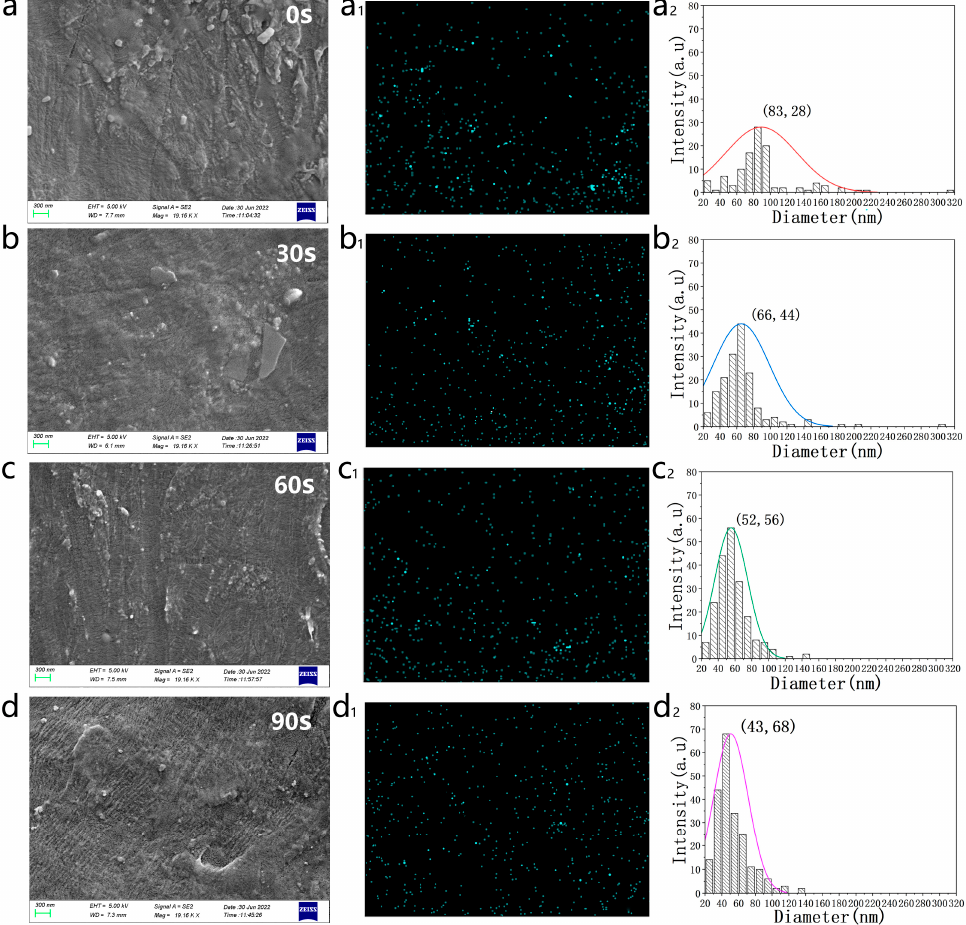
Figure 3. FESEM images of surface morphology and NPs dispersion in ZnO/LDPE films made by plasma-treated NPs: ( a – d ) FESEM images of the films made of ZnO treated by plasma for 0 s, 30 s, 60 s, 90 s; ( a 1 – d 1 ) EDS mapping of NPs in films made of ZnO treated by plasma for 0 s, 30 s, 60 s, 90 s; and ( a 2 – d 2 ) particle-size distribution of NPs in films made of ZnO treated by plasma treatment for 0 s, 30 s, 60 s, 90 s.